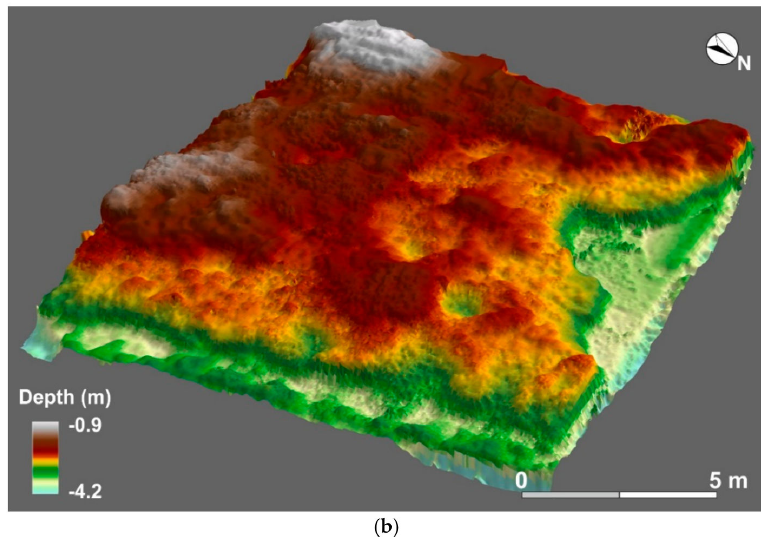
Figure 18. 3D point cloud with the perimeter of the outcropping areas in hydraulic concrete (light-dark dashed line). ( a ) Cloud point visualisation by using Cloud Compare software; and ( b ) pilaDTM visualisation by using the ArcScene software.